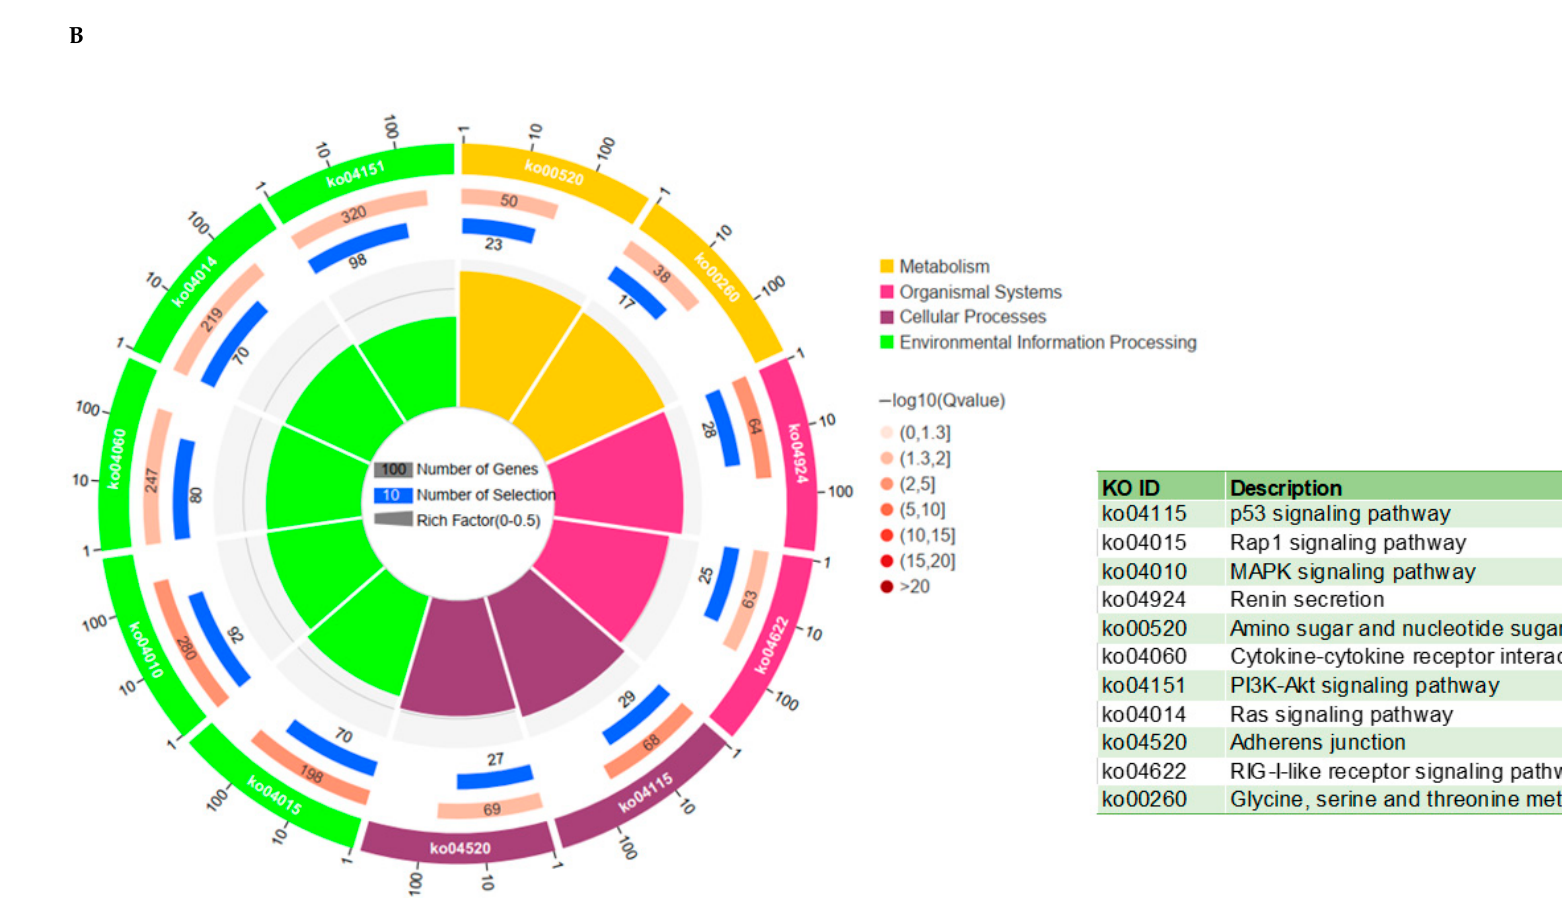
Figure 9. Function enrichment analysis of transcriptomic data. ( A ) Top 20 enriched GO terms of the DEGs. The first lap indicates the top 20 GO terms, and the number of the genes corresponds to the outer lap. The second lap indicates the number of genes in the genome background and p -value for enrichment of the differentially expressed genes (DEGs) for the specified biological process. The third lap indicates the DEG number. The fourth lap indicates the rich factor of each GO term. ( B ) Significantly enriched KEGG pathways from differentially expressed genes (DEGs). The first lap represents the significantly enriched pathways’ ID, and the number of genes corresponds to the outer lap. The second lap represents the number of genes in the genome background as well as the Q-value for pathways. The third lap represents the DEG number. The fourth lap shows the rich factor of each KEGG pathway. P -value < 0.05 and Q value < 0.05 were considered significant in GO and KEGG analyses,